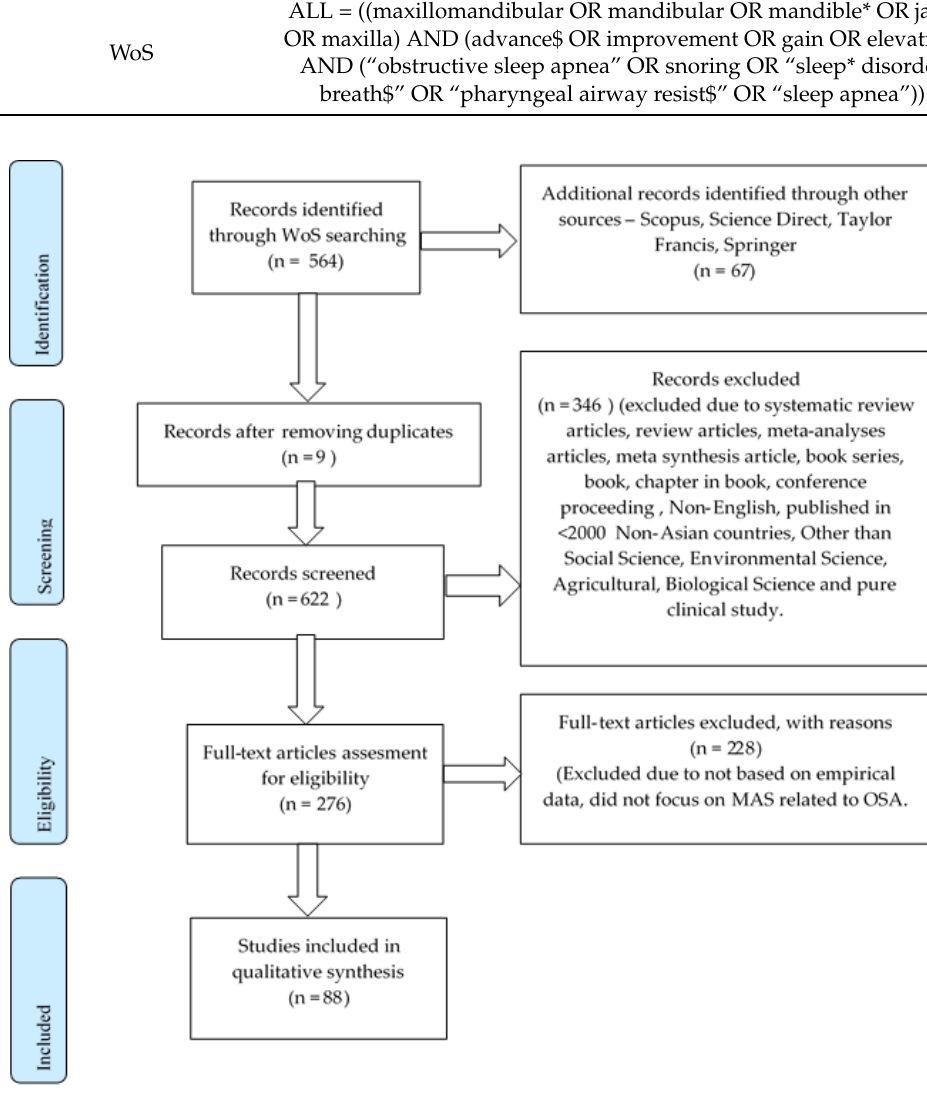
Figure 1. Flow chart of the review screening